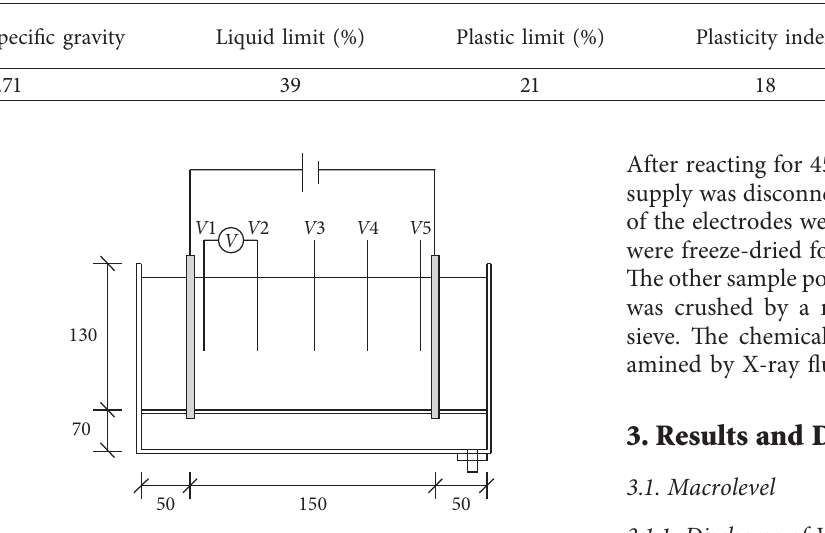
Table 1: Summary of the geotechnical properties and mineral composition.